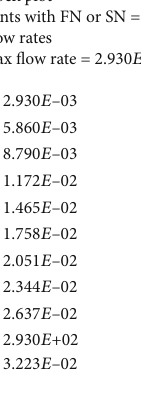
Figure 3: The fl ow distribution in initial caving of direct roof.